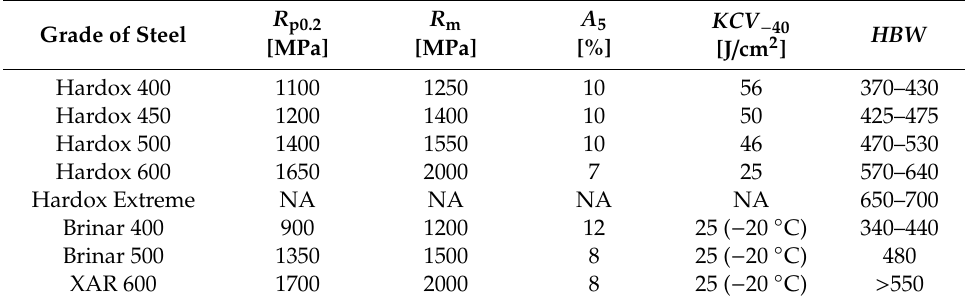
Table 1. Declared mechanical properties of selected abrasive-wear resistant steels [1–5].